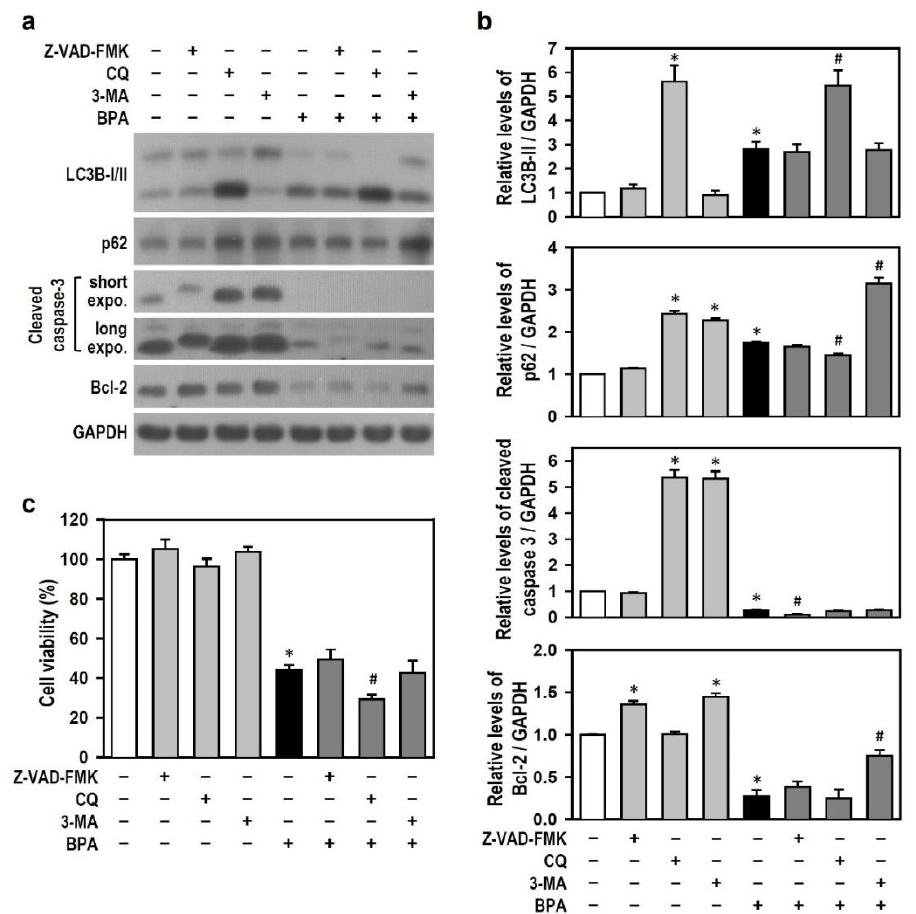
the pattern of LC3 puncta. A bar plot shows the relative quantitation results of LC3B immunoreactivity in cultures. Data are represented as mean ± SEM ( n = 3). * p < 0.05 vs. vehicle group.